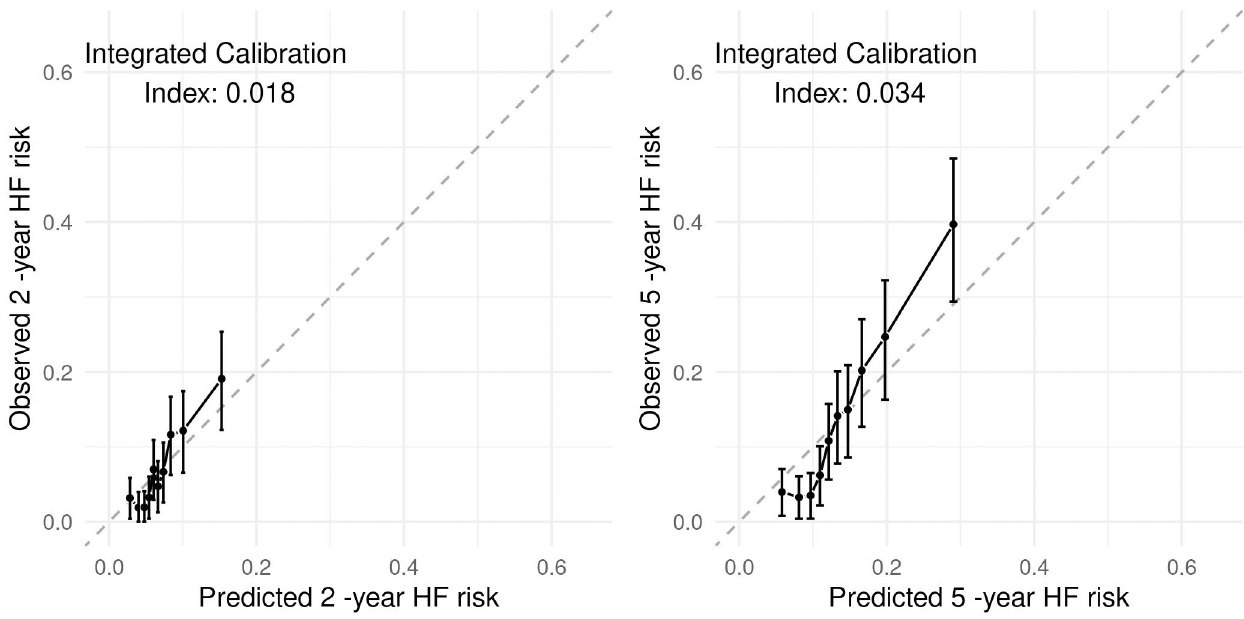
Fig 2. Calibration for COX model. Deviations from the diagonal line denote lack of calibration.